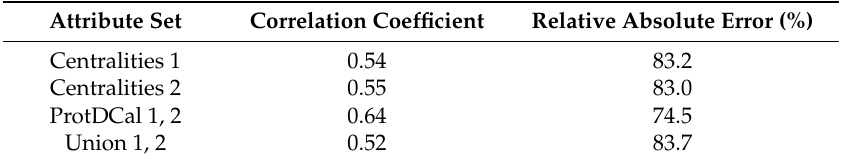
Table 5. Leave-One-Out Test for